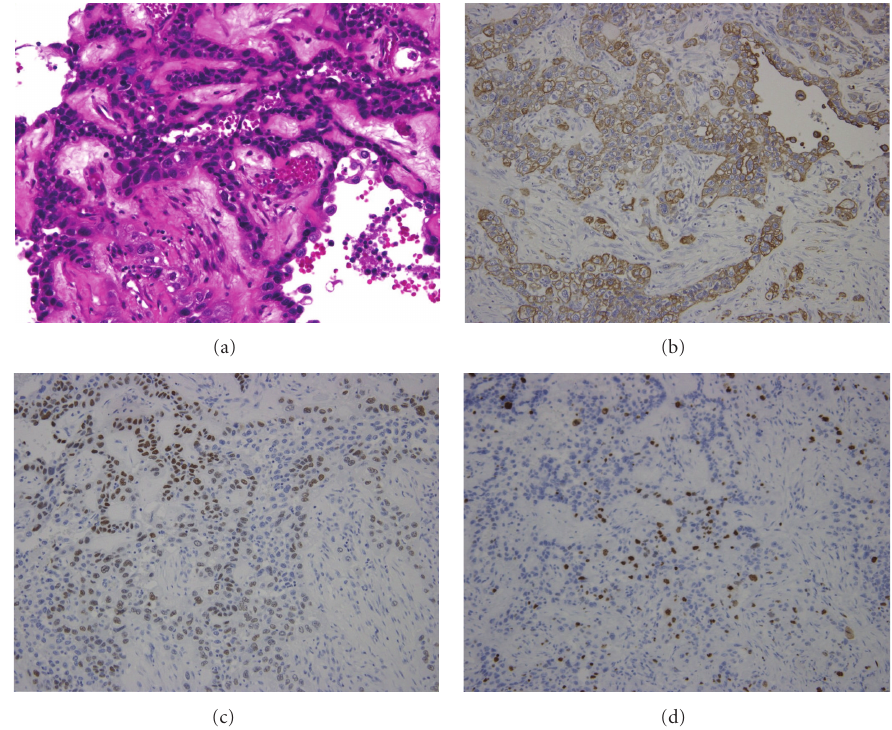
Figure 3: (a) Tubular structures with an inner layer of cuboidal epithelial cells and an outer layer of myoepithelial cells with clear cytoplasm. Mitoses were not conspicuous (hematoxylin-eosin, original magnification × 200). (b) Immunoreactivity in epithelial cells for cytokeratin (original magnification × 200). (c) Immunoreactivity in myoepithelial cells for p63 (original magnification × 200). (d) Immunoreactivity for the MIB-1 was about 10% (original magnification ×